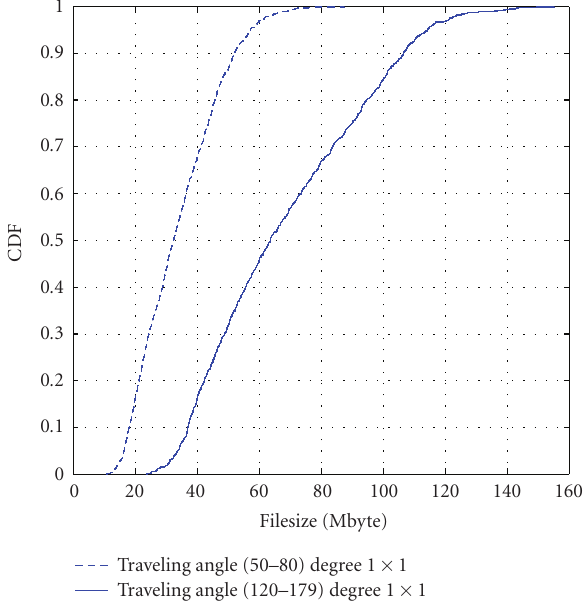
Figure 7: CDF of data download when velocity of user changes time to time along the traveling